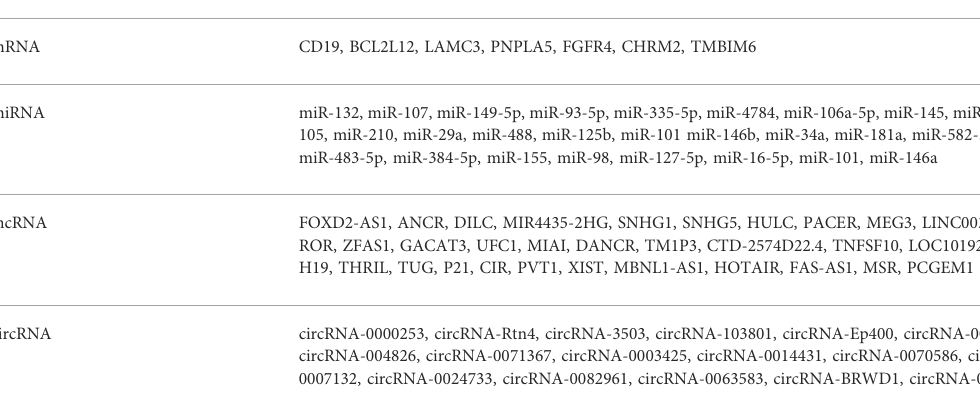
TABLE 3 Exosomes RNA in orthopedics. Sort RNA in exosome